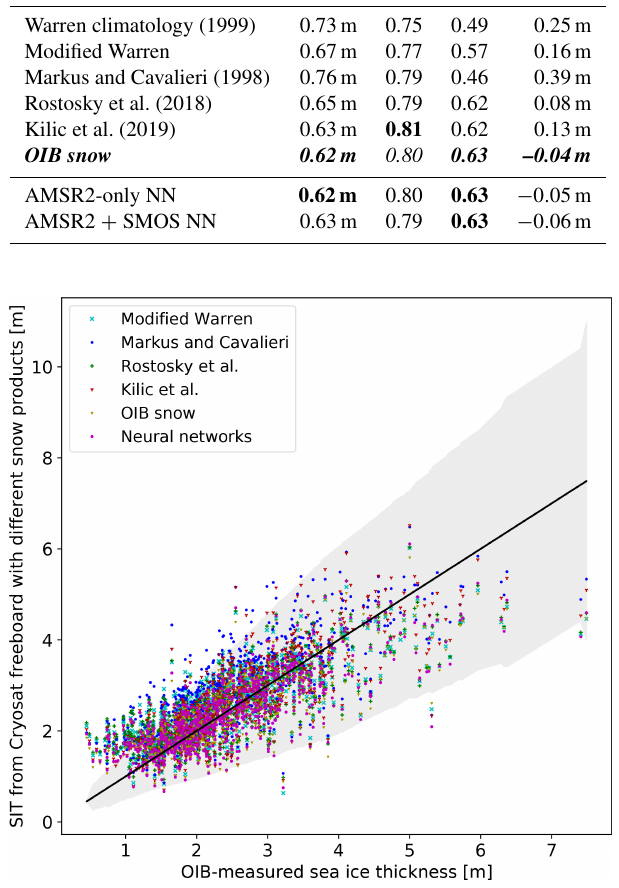
Figure 9. OIB-measured SIT (all data) versus estimated SIT using CryoSat freeboard with different snow depth